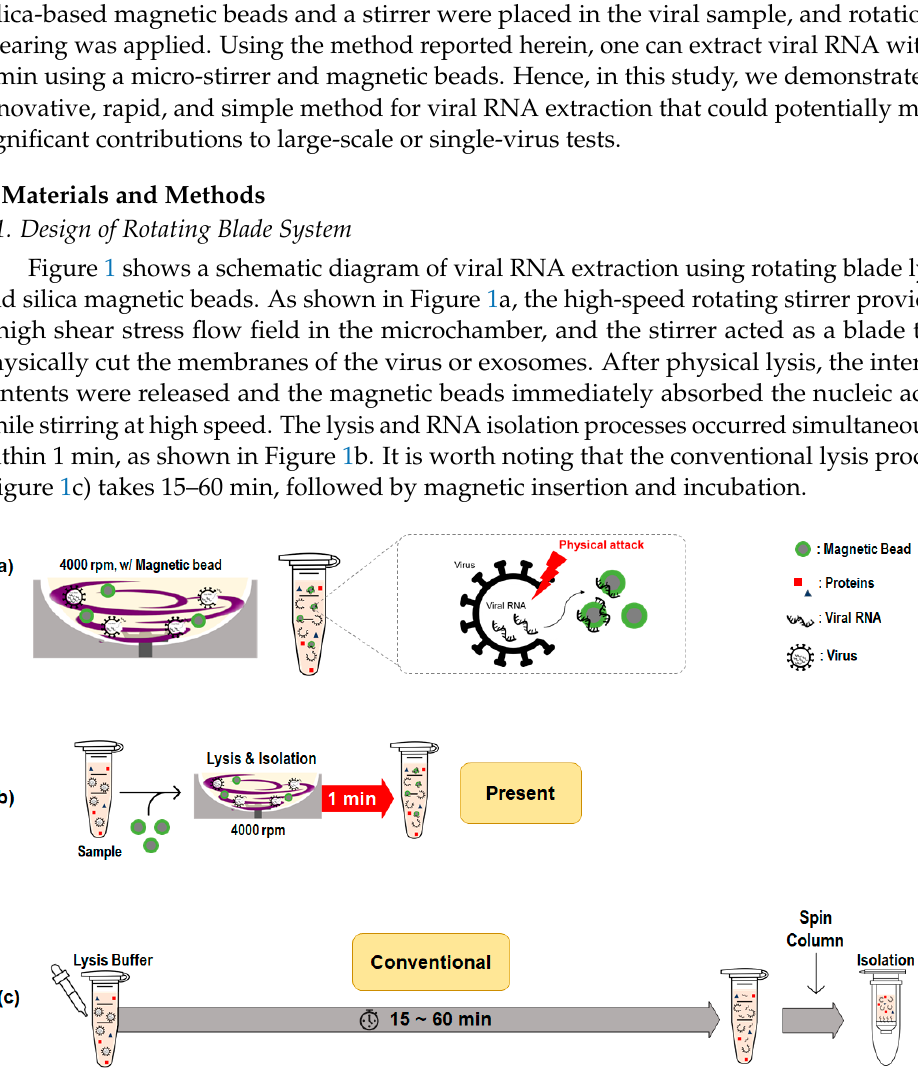
Figure 1. Schematic of viral RNA extraction using rotating blade lysis and silica magnetic beads. ( a ) Pathogen lysis using a high-speed rotating blade in a microwell; ( b ) Present method: Simultaneous lysis and isolation of viral RNA; ( c ) Conventional method: Stepwise lysis and spin-column extrac- tion.